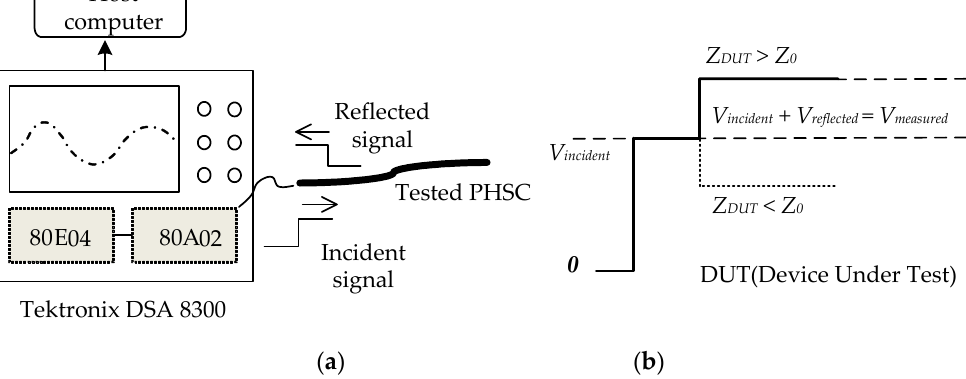
Figure 2. Diagram of tensile test platform and waveform ( a ) tensile test platform based on the time–domain reflectometry (TDR) technique; ( b ) a typical step signal incident and measured waveform.